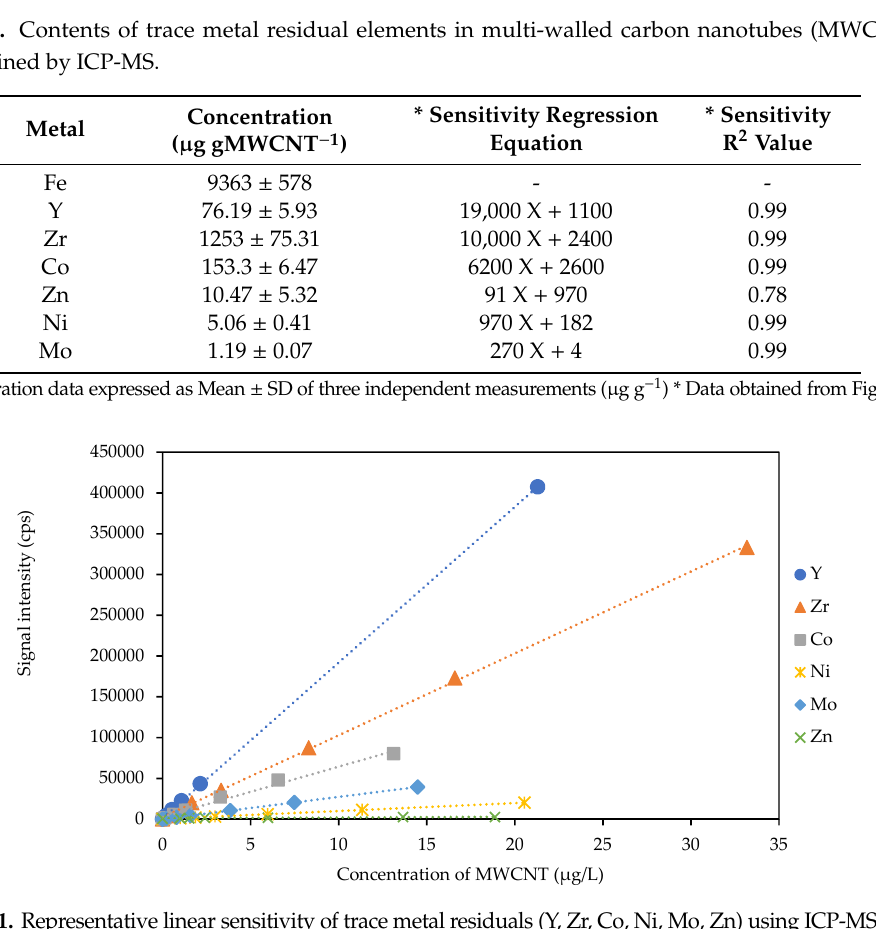
Figure 1. Representative linear sensitivity of trace metal residuals (Y, Zr, Co, Ni, Mo, Zn) using ICP-MS for a range of MWCNT concentrations dosed into water. The ratio of net signal to concentration is the sensitivity of each element (see Table 1).